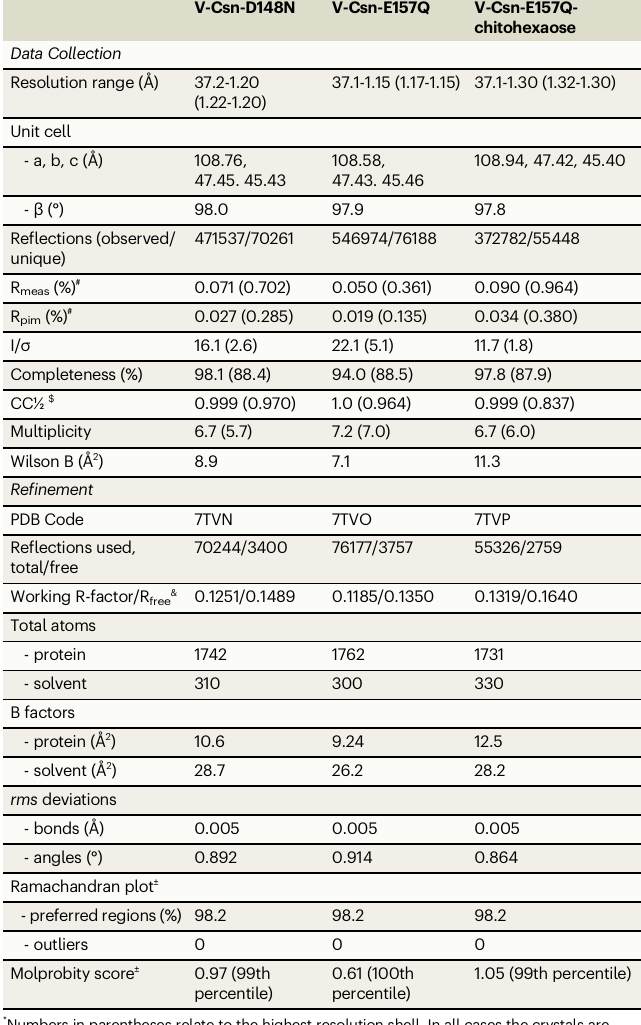
Table 3 | V-Csn mutant data collection and re fi nement statistics* V-Csn-D148N